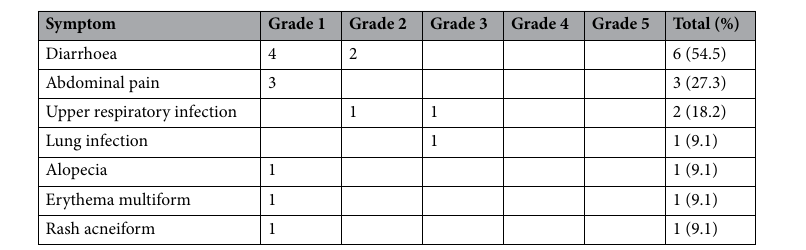
Table 3. Adverse events following resveratrol administration. The numbers of patients are indicated.